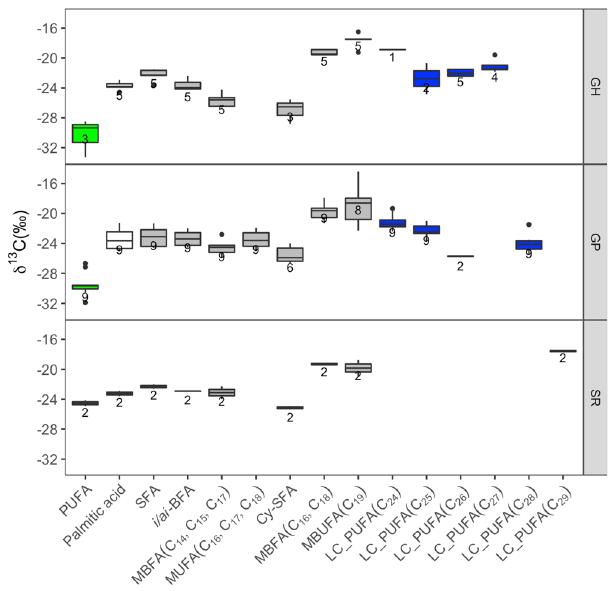
Fig. 5 Compound-speci fi c isotope analyses on sponge PLFAs. Compound- speci fi c δ 13 C ( ‰ ) on PLFA on the three sponge species analyzed: G. parva (GP) G. hentscheli (GH), and S. rhaphidiophora (SR). Different biomarkers were color code: palmitic acid (C16:0, white), bacteria-speci fi c (gray), algae-speci fi c (green), and sponge-speci fi c (blue) markers. The lower and upper hinges of the boxes correspond to the 25th and 75th percentiles and the whiskers represent the 1.5x inter-quartile range (IQR) extending from the hinges. The median is indicated in the box plot as a solid line. The number in the plot indicates biological independent specimen. Source data are provided as a Source Data fi le. PUFA polyunsaturated fatty acids (FA), SFA straight-chain saturated FA, i/ai -BFA iso/anteiso branched C 15 -C 17 FA, MBFA mid-methyl-branched FA, MUFA monounsaturated FA, Cy-SFA cyclopropyl-saturated FA, MBUFA mid-methyl-branched- unsaturated FA, LC_PUFA long-chain polyunsaturated